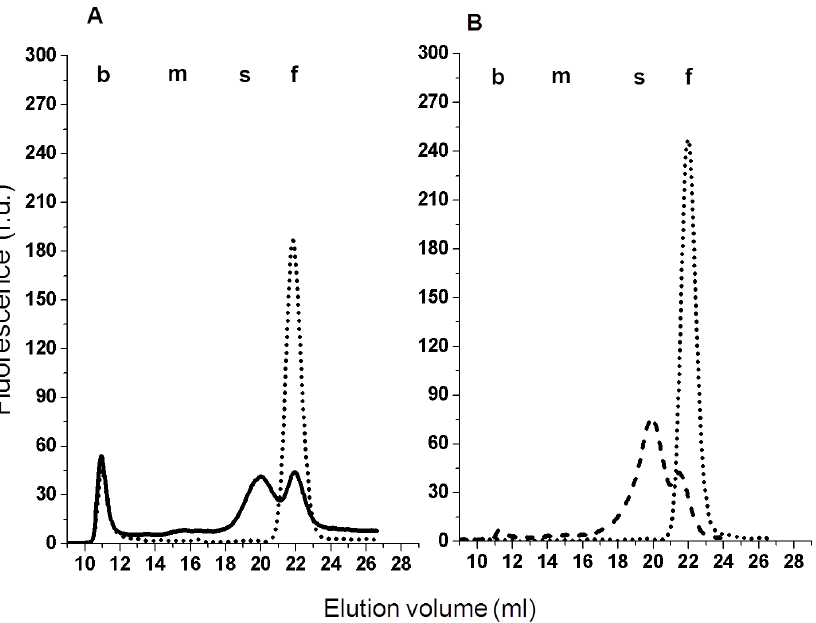
Figure 2. Papain and DOC effects on plasma samples. Effect of papain (25 mmol/l, 24 h, RT) and DOC (1% w/v, 1 h, 37 u C) treatments on GGT fractions in a plasma sample representative of four independent experiments. A) GGT-specific elution profile in the untreated control [continuous line; GGT activity (U/L): total=38.8; b-GGT=8.9; m-GGT=3.1; s-GGT=14.1; f-GGT=12.6] and after papain treatment [dotted line; GGT activity (U/L): total=49.8; b-GGT=7.5; m-GGT=n.d.; s-GGT=n.d.; f-GGT=42.3]. B) GGT-specific elution profile after DOC treatment [dashed line; GGT activity (U/L): total=45.0; b-GGT=1.3; m-GGT=2.4; s-GGT=31.2; f-GGT=10.1] and after DOC and papain treatments [dotted line; GGT activity (U/L): total=57.0; b- GGT=n.d.; m-GGT=n.d.; s-GGT=n.d.; f-GGT=57.0]. n.d.: not detectable.